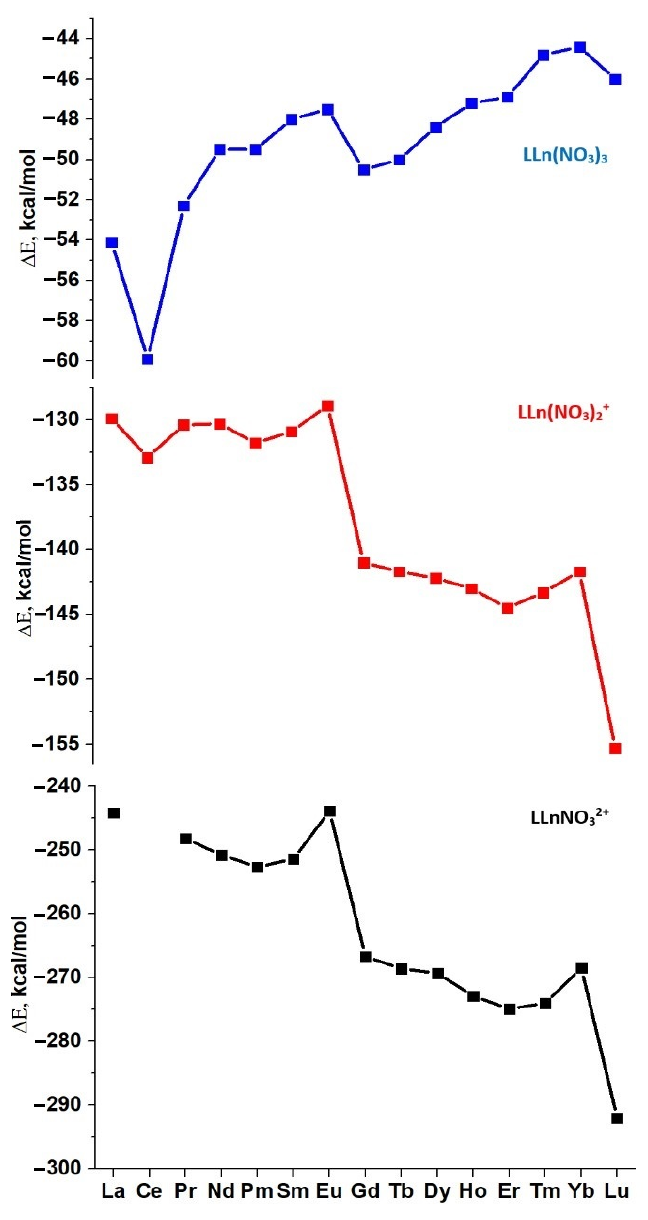
Figure 4. Calculated binding energies ∆Е for successive addition of nitrate anions to the [ L2 Ln] 3+ , [ L2 Ln(NO 3 )] 2+ , [ L2 Ln(NO 3 ) 2 ] + , and L2 Ln(NO 3 ) 3 complexes (gas phase conditions).